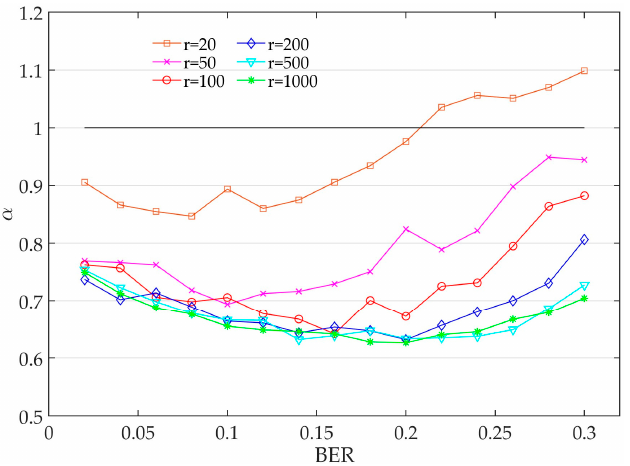
Figure 8. Value of α versus bit error rate (BER) under different r . r , the columns of interception matrix C .